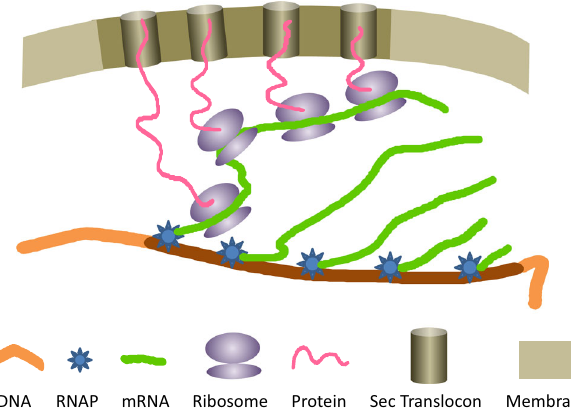
DNA Fig. 1 | Schematic presentation of transertion. If the processes of transcription, translation, and membrane insertion occur simultaneously at any point in the biogenesis of a cytoplasmic-membrane protein, then the chromosomal locus encodingthatproteinistransientlytetheredtothemembrane.Onlyonepolysome is shown for